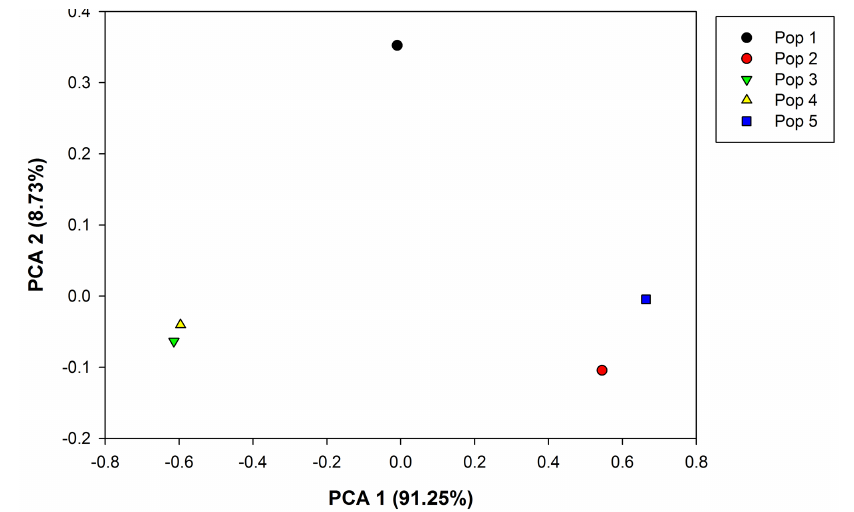
Figure 4. Scatter plot by Principal Coordinate Analysis based on Nei’s genetic distance for the five populations obtained from interspecific crosses of Psidium